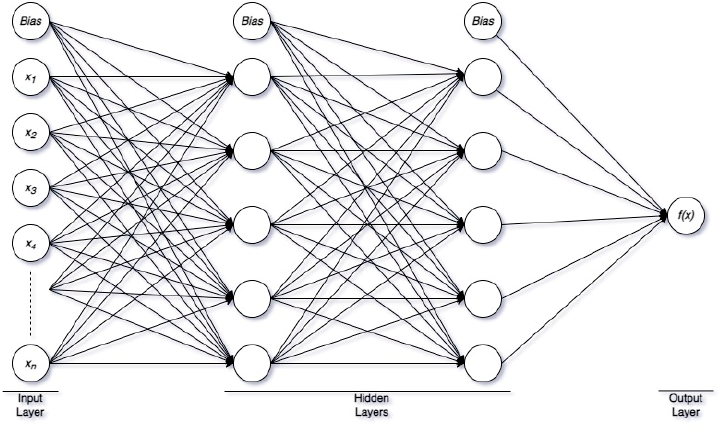
Figure 5. A schematic of a simple neural network used in MLP.